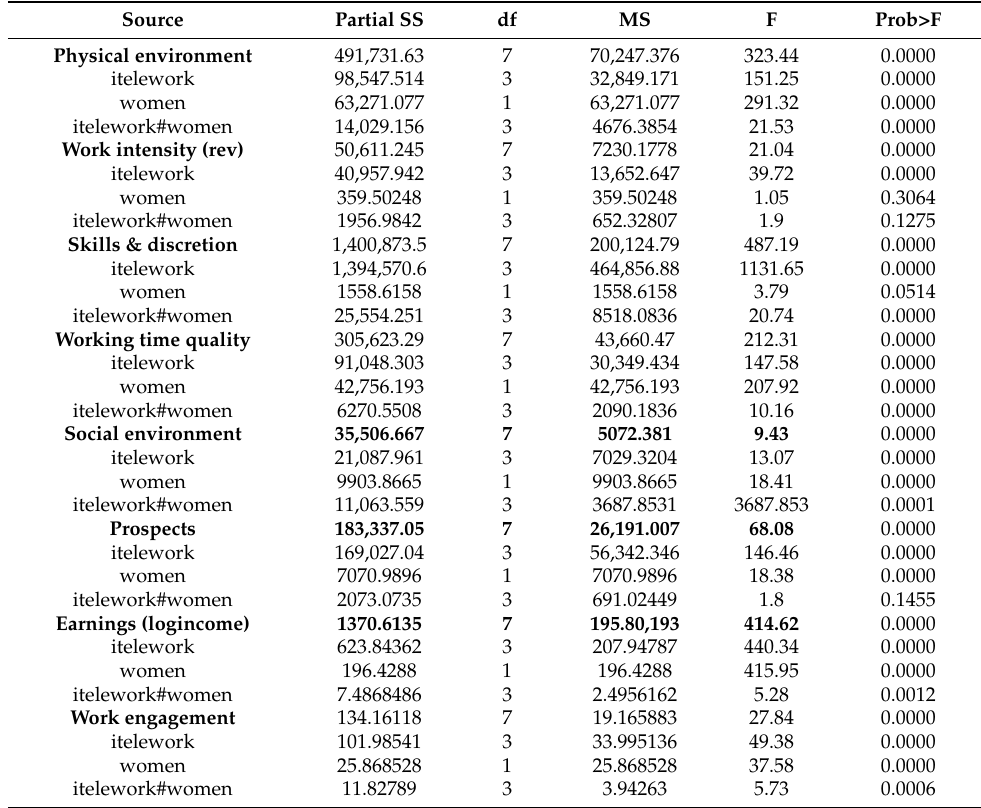
Table A1. Two-way ANOVA results for intensity of teleworking, gender and their interaction. Source: Own elaboration based on 6th EWCS